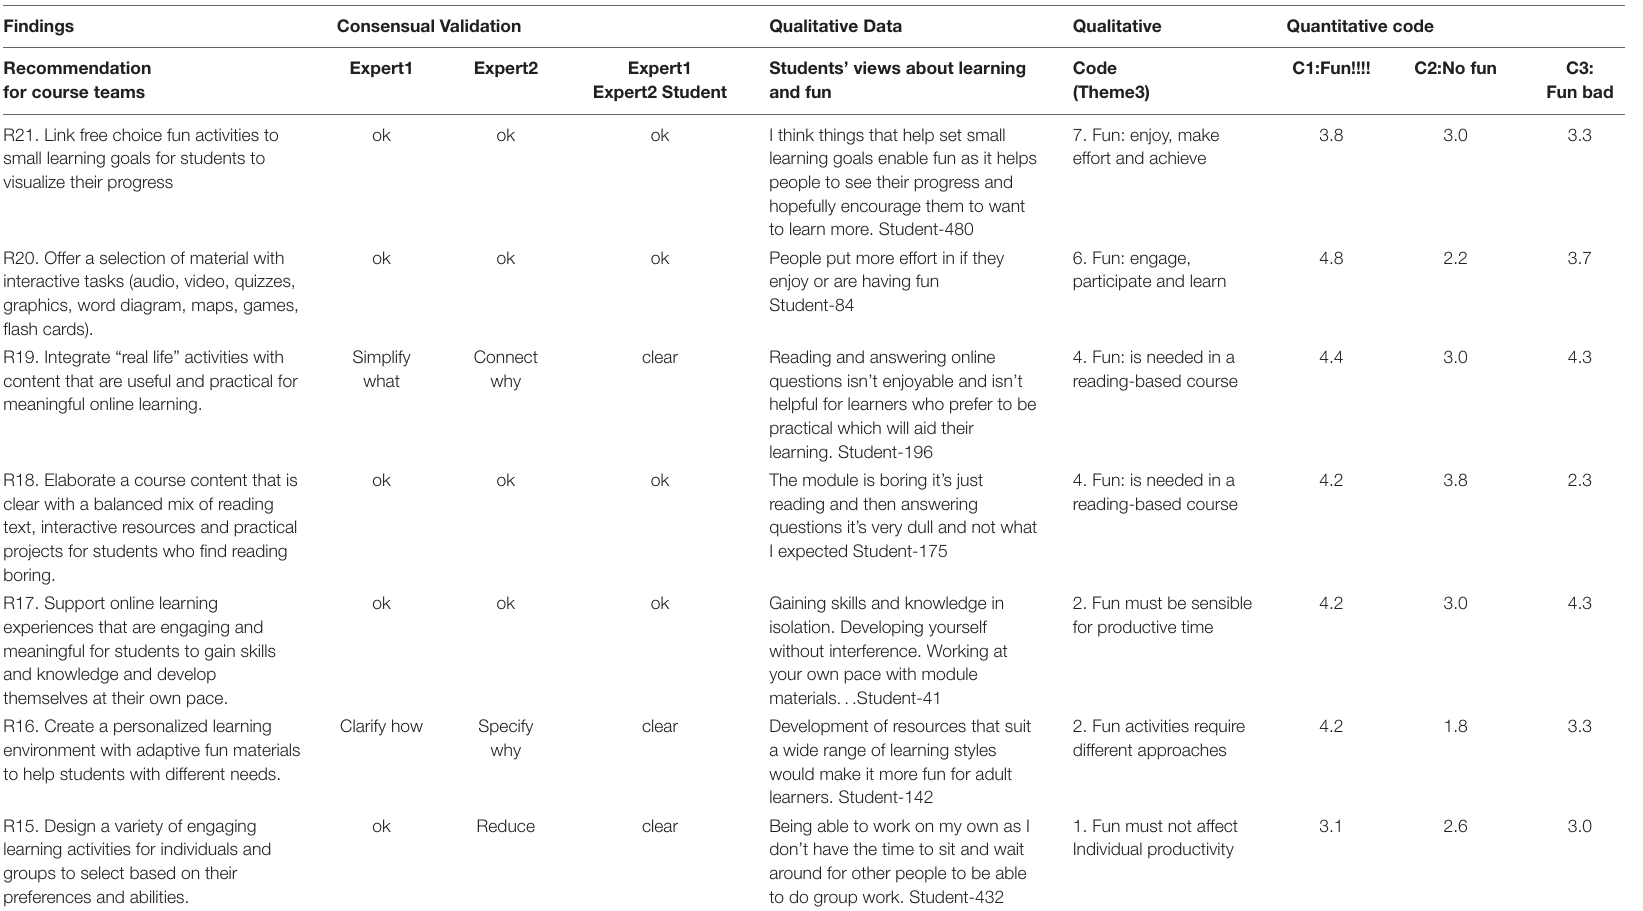
TABLE 5 | Recommendations about Online Learning and Fun for course teams supported by mixed methods.